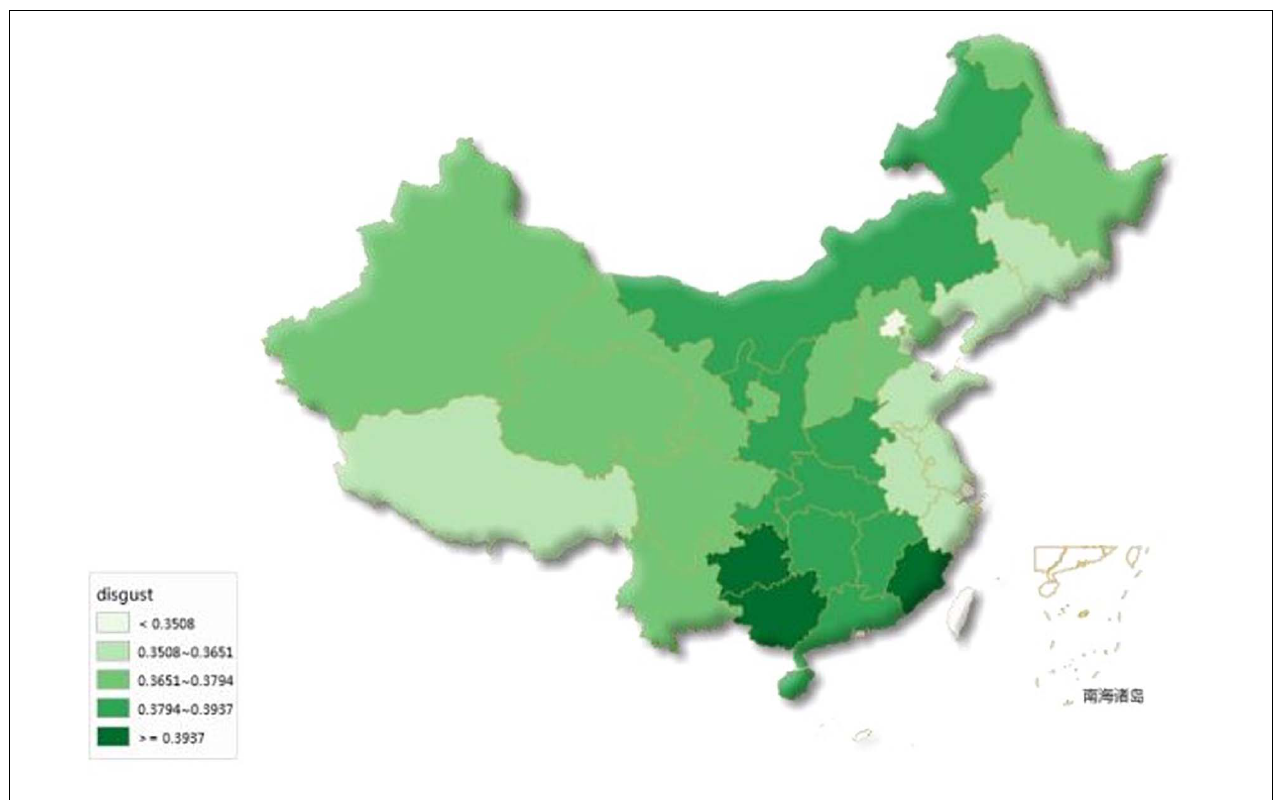
FIGURE 1 | Online disgust of 31 provinces in China,